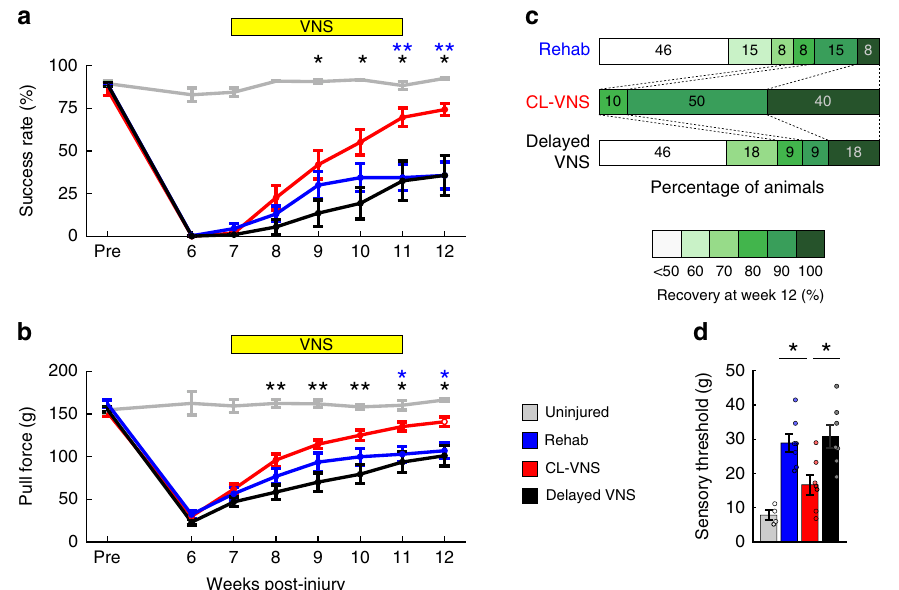
Fig. 3 Closed-loop VNS delivered during rehabilitative training improves motor and sensory function after nerve damage. a , b Closed-loop VNS paired with rehabilitation (CL-VNS, n = 10) signi fi cantly enhances recovery of volitional forelimb function compared to equivalent rehabilitation without CL-VNS (Rehab, n = 13). Consistent with the failure to restore cortical motor maps, Delayed VNS ( n = 11) fails to improve recovery compared to CL-VNS. c Plots depicting the proportion of subjects in each group sorted by percentage of pull force recovery. All CL-VNS subjects recovered at least 80% of pre-injury function by the end of therapy. Subjects receiving either Rehab or Delayed VNS exhibited substantially reduced levels of recovery, with many subjects demonstrating < 50% recovery. Same group sizes as in a , b . d CL-VNS ( n = 7) signi fi cantly improved tactile sensation in the denervated forepaw compared to both Rehab ( n = 7) and Delayed VNS ( n = 7) groups. In a , b asterisks indicate signi fi cant differences using t -tests across groups at each time point. The color of the asterisk denotes the group compared to CL-VNS (blue indicates CL-VNS v. Rehab, and black indicates CL-VNS v. Delayed VNS). Circles depict individual subjects in d . Error bars indicate S.E.M. All comparisons represent Bonferroni-corrected t -tests to CL-VNS, *** p < 0.0005, ** p < 0.005, * p < 0.025. Source data are provided as a Source Data fi